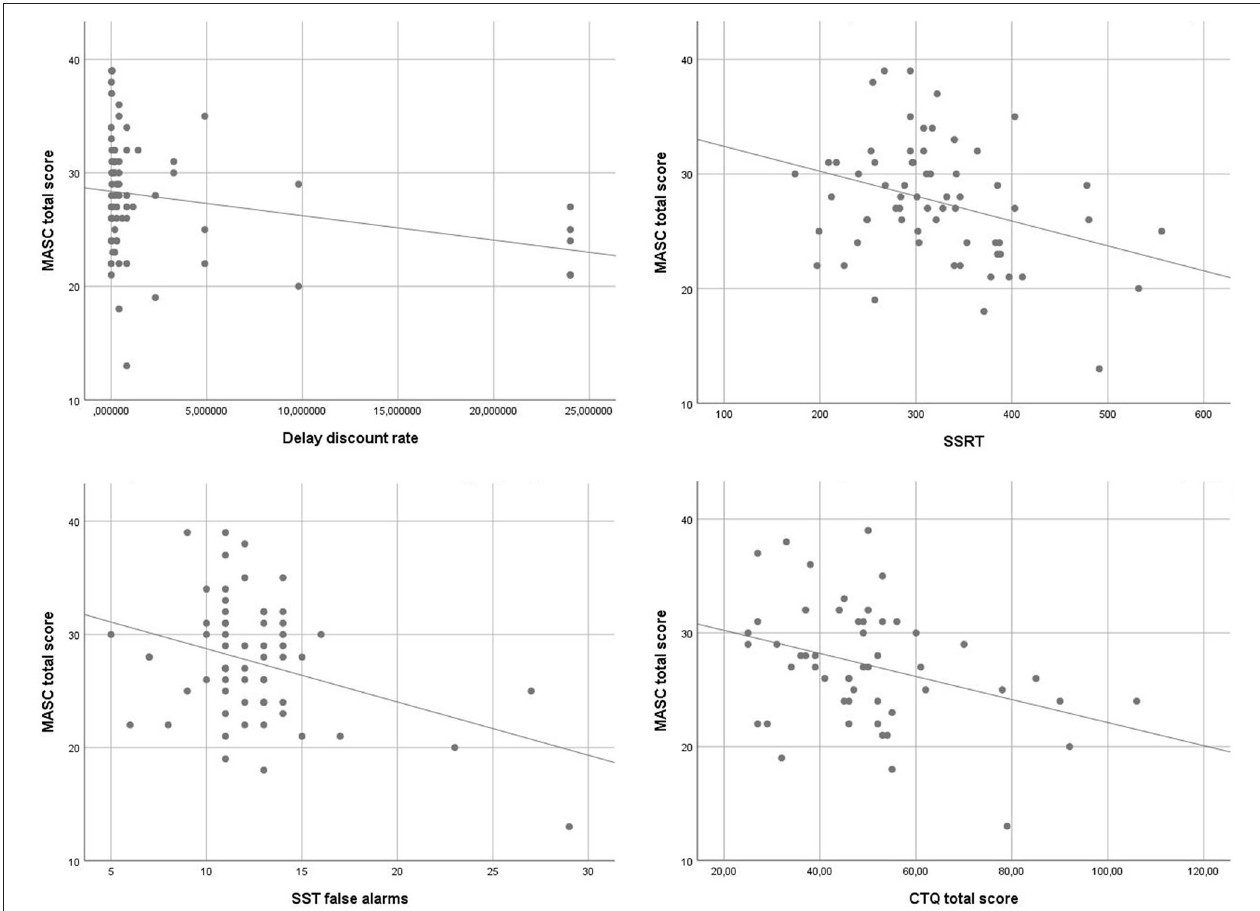
FIGURE 1 | Scatterplots of correlations between MASC score, executive functions and CTQ.